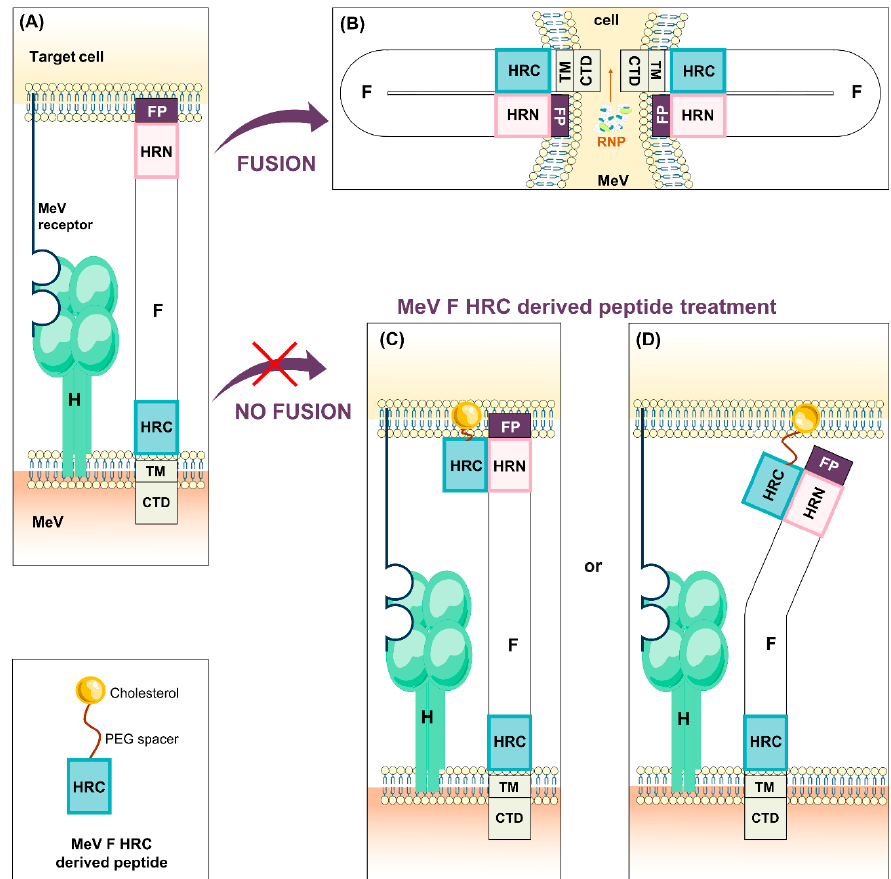
Figure 6. MeV F heptad repeats at the C terminal domain (HRC)-derived peptide . Following